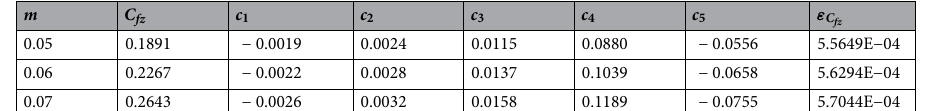
Table 6. Numerical computations for quadratic regression coefficients and error bound for estimated C fz Re